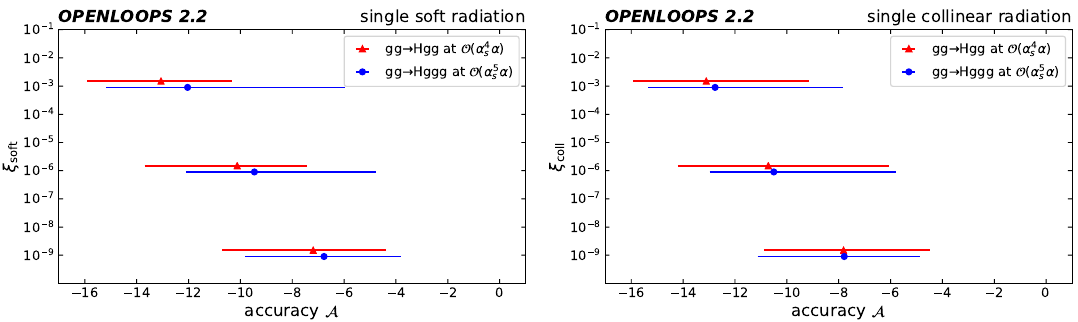
Figure 1 . Stability plots in IR regions for one-loop-squared matrix elements in gg ! Hgg and gg ! Hggg versus the degree of collinear (cid:24) coll or soft (cid:24) soft singularity obtained with OpenLoops2.2 . For each value of (cid:24) , the numerical accuracy is calculated with a sample of 10 3 randomly soft/coll distributed infrared events. Unstable points are detected by a rescaling test and rescued if the relative accuracy of 10 (cid:0) 6 is not reached. The rescue step reevaluates the tensor integrals to quad precision. The accuracy of the so-obtained value is determined by comparing it to a quadruple precision benchmark whose accuracy is also assessed by a rescaling test. The plotted central points and variation bands correspond, respectively, to the average and 100% confidence interval of A